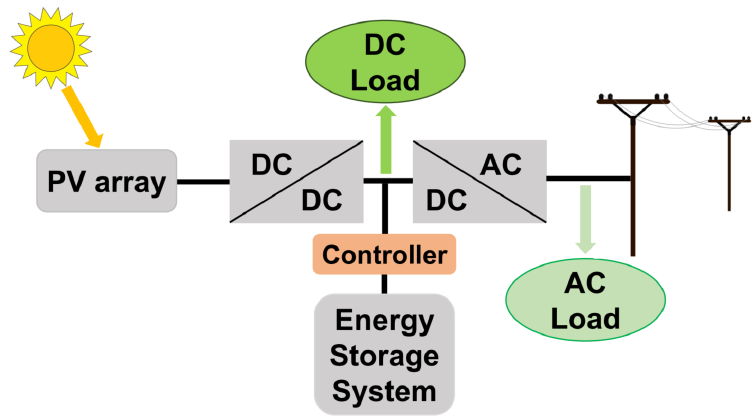
Figure 7. Schematic of a general PV system